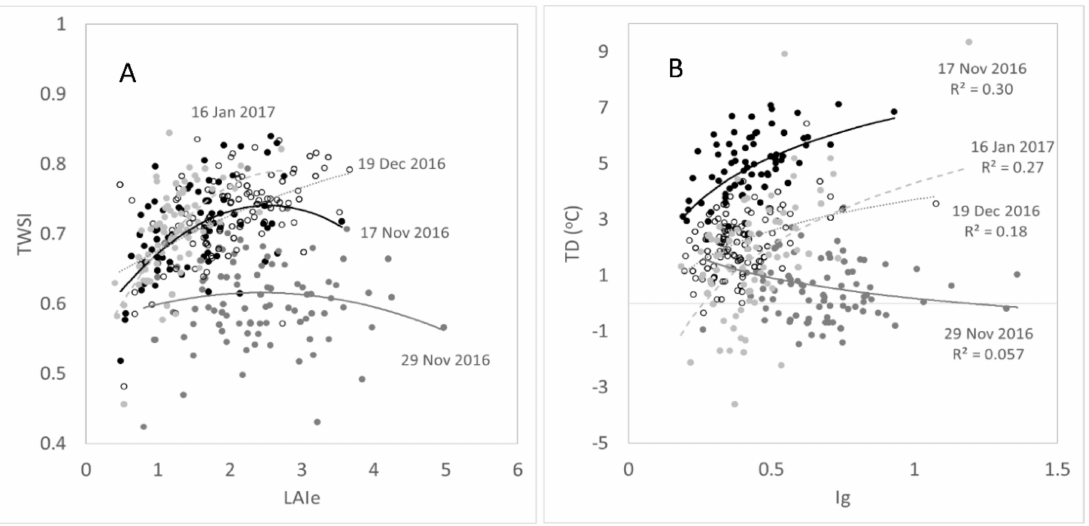
Figure 6. Comparison between effective leaf area index ( LAIe , dimensionless) and tree water stress index (TWSI) ( A ), and between the infrared thermal index ( Ig ) and temperature depression (TD, ◦ C) ( B ) for 172 elm trees monitored along the Royal Parade in Melbourne, Australia for four different dates between 2–16 and 2017, using the proposed urban tree monitoring